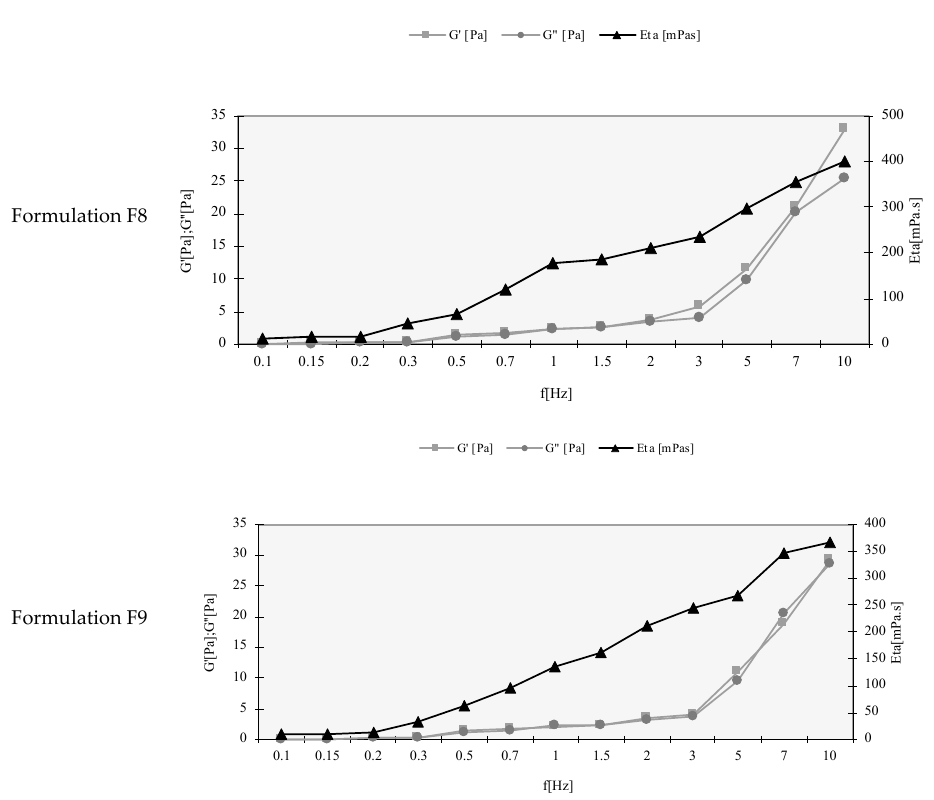
Figure 1. Rheological profiles of the storage modulus (G’), loss modulus (G’’) and the complex viscosity ( η * ) of triamcinolone acetonide-loaded nanoemulsions at a constant stress amplitude of 5 Pa.